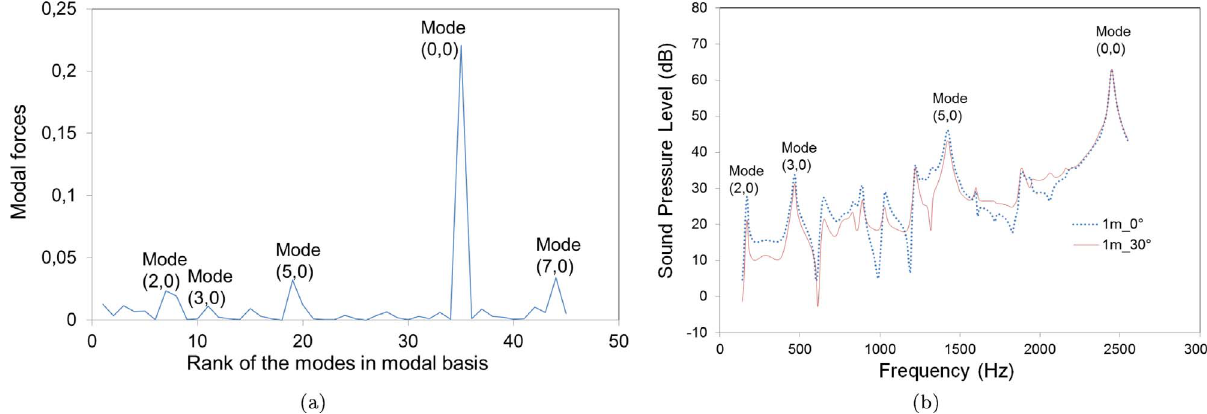
Figure 9. Modal forces in N (a) and simulated acoustic response of Coil55 at 1 m for a 45 A RMS single component